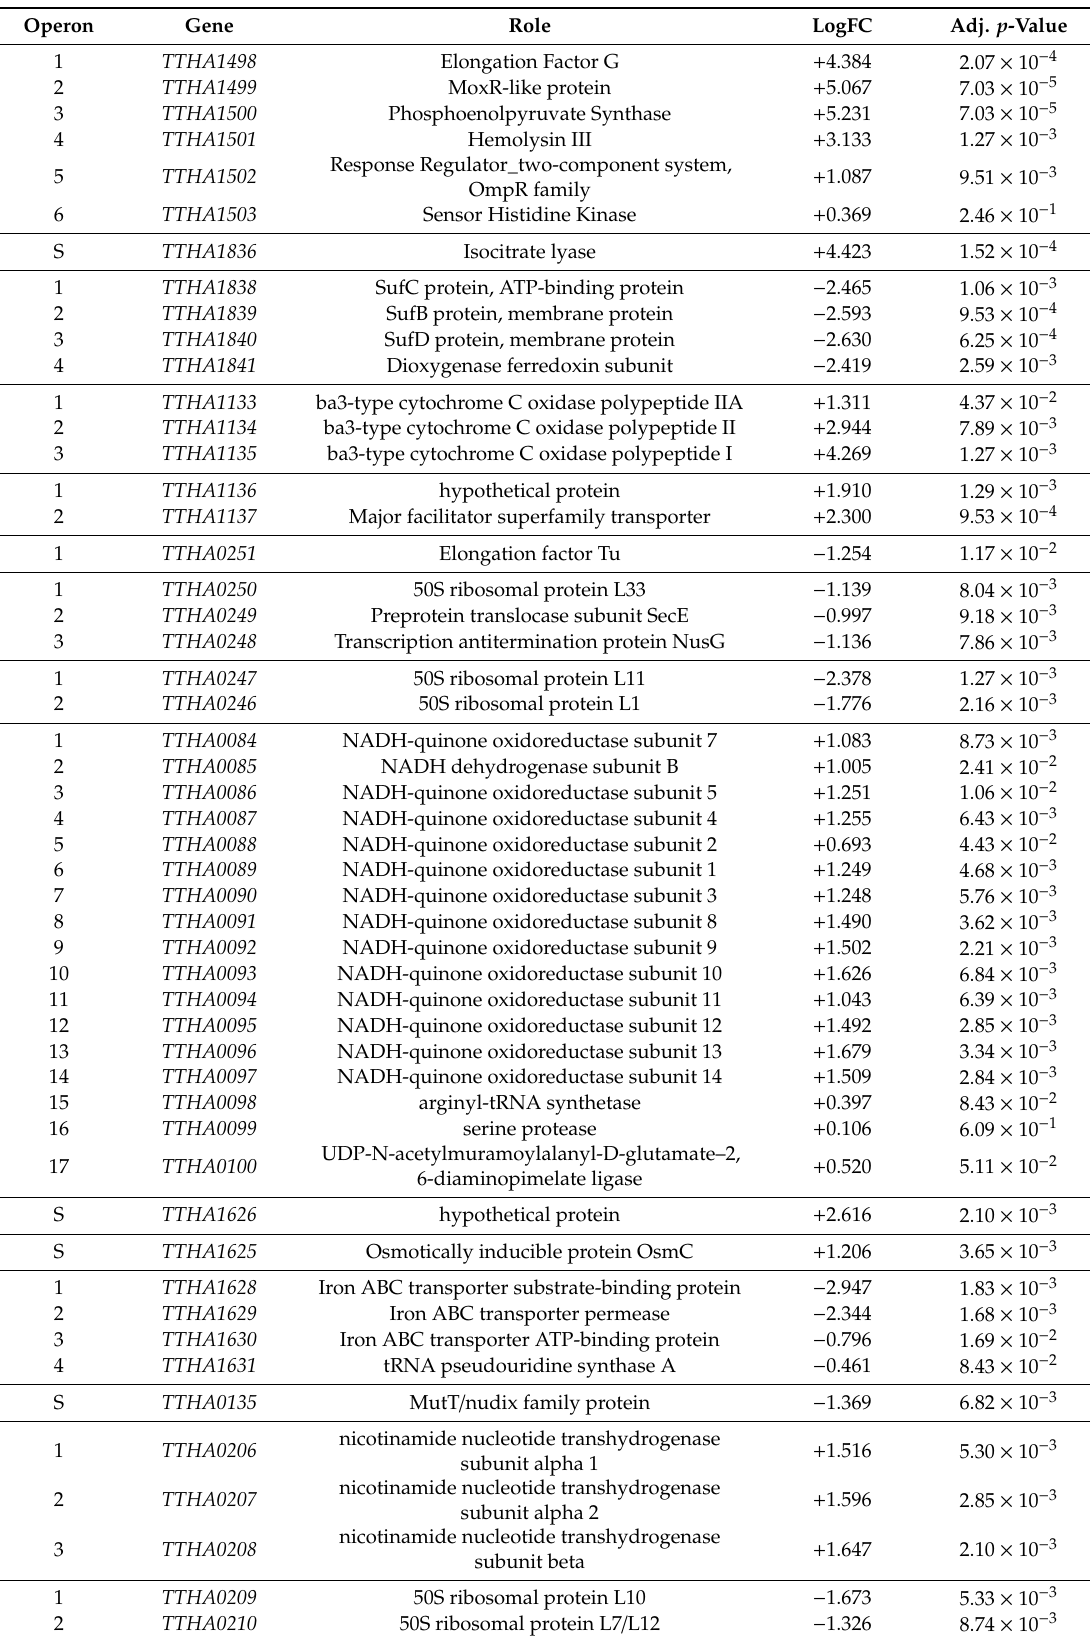
Table 5. GEO2R analysis of the most a ff ected genes in the absence of TTHB099.